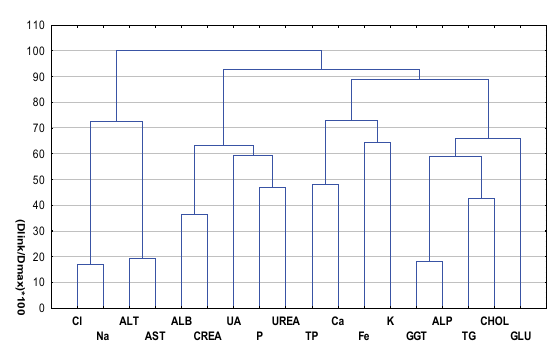
Figure 4. Hierarchical dendrogram of biochemical variables for all (ESRF) patients.